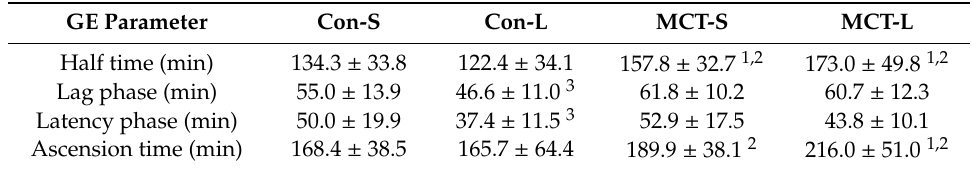
Table 1. Gastric emptying (GE) half time, lag phase, latency phase and ascension time of all participants ( n = 29). Values are means ±